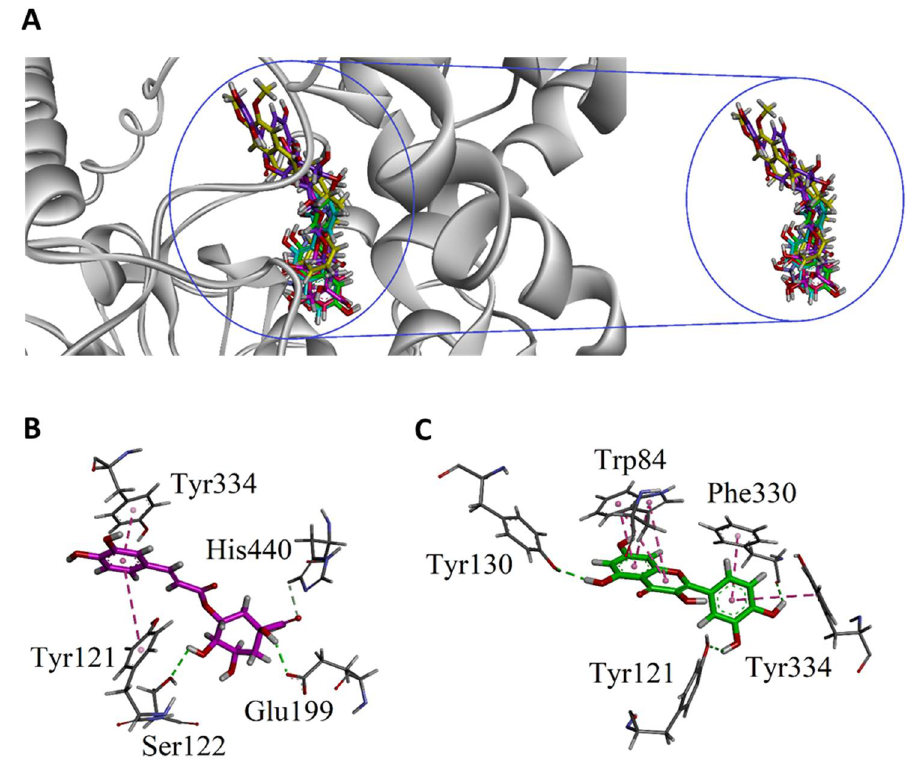
Figure 5. The overlaid ribbon diagram of all the constituents and native ligand donepezil (yellow) into the binding site of TcAChE (1EVE) ( A ). Close-up view interaction plots of the docked pose showing important residues with chlorogenic acid ( B ) and quercetin ( C ).